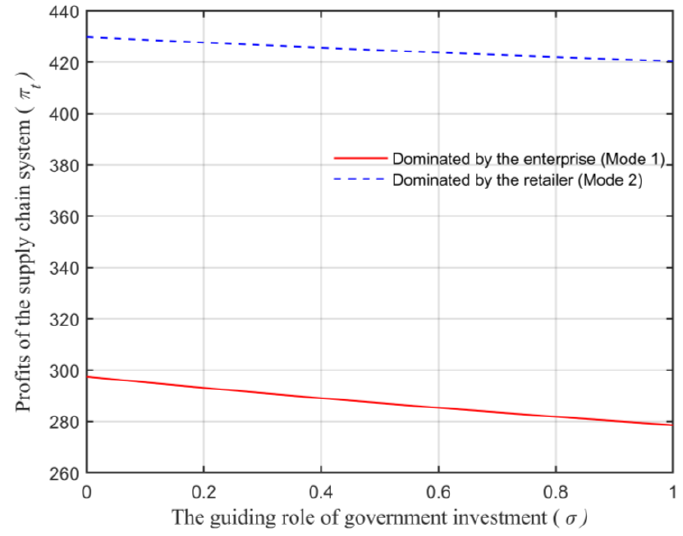
Figure 11. The relationship between the guiding role of government investment and the supply chain system’s overall profits.